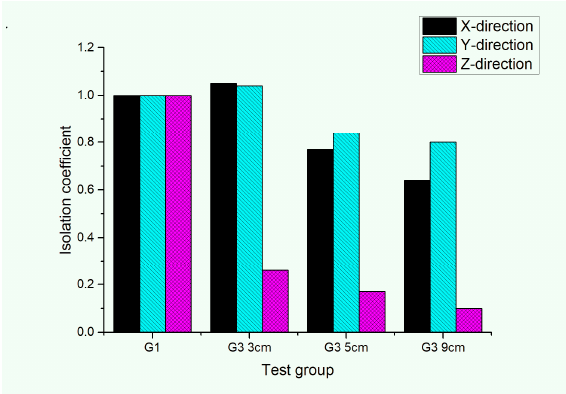
Figure 6. Isolation coefficient of the composite subgrade structure.